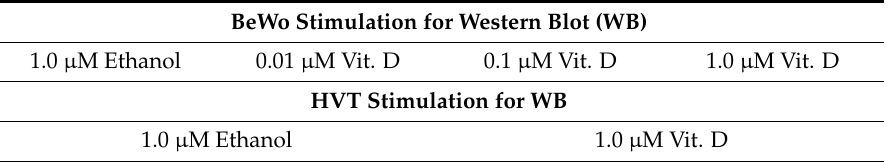
Table 3. Cell culture stimulation